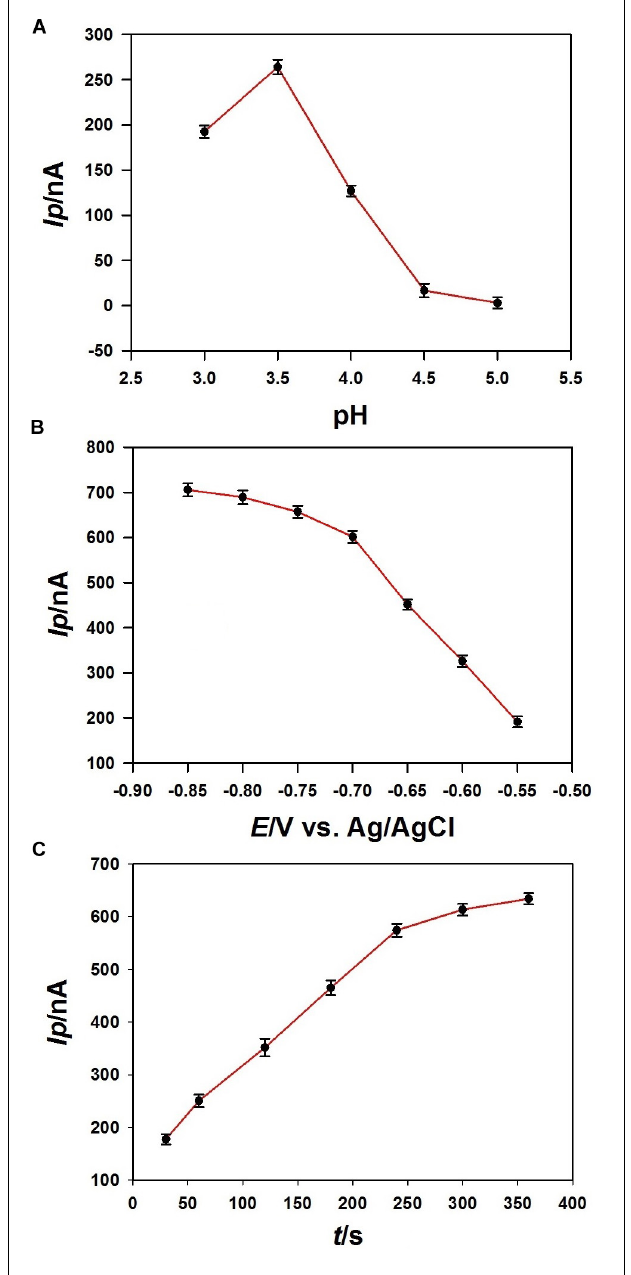
FIGURE 7 | Effects of pH (A) , accumulation potential (B) , and accumulation time (C) on the peak current (Ip) of 1 µ mol L − 1 Pb 2 + ( n = 3) obtained at the